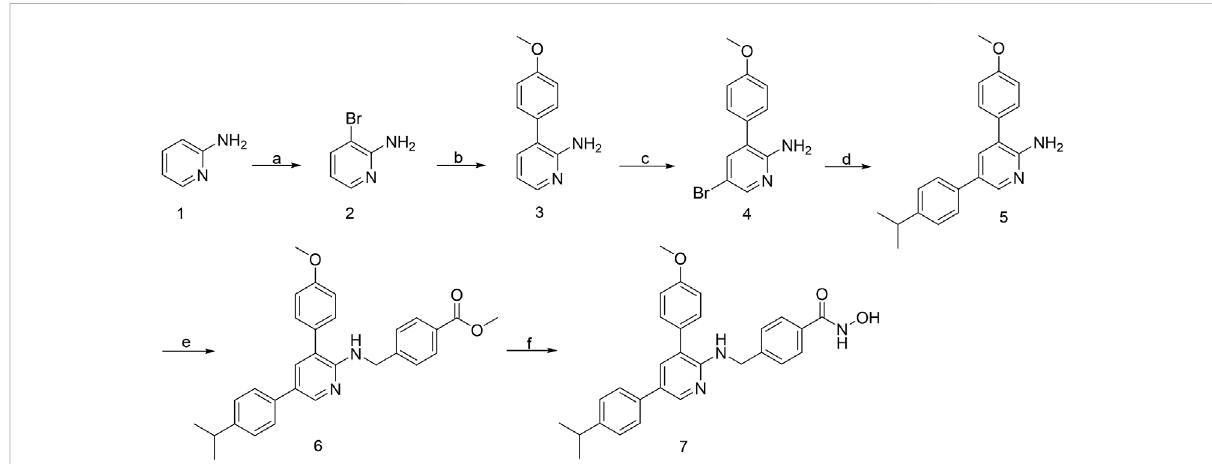
FIGURE 1 Synthetic route of compound H42. Reagents and conditions: (a) NBS, THF, rt; (b) Na 2 CO 3 , Pd (pph3) 2Cl 2 , 4-methoxyphenylboronic acid, 1,4- dioxane-H 2 O (5:1), 110 ° C, re fl ux; (c) NBS, THF, rt; (d) Na 2 CO 3 , Pd (pddf) Cl 2 , 4-isopropylphenylboronic acid, 1,4-dioxane-H 2 O (5:1), 110 ° C, re fl ux; (e) NaH, methyl 4-(bromomethyl) benzoate, super dry THF, rt; and (f) 1) hydroxylamine (50% water), NaOH, DCM-MeOH (1:2); 2) formic acid, water.